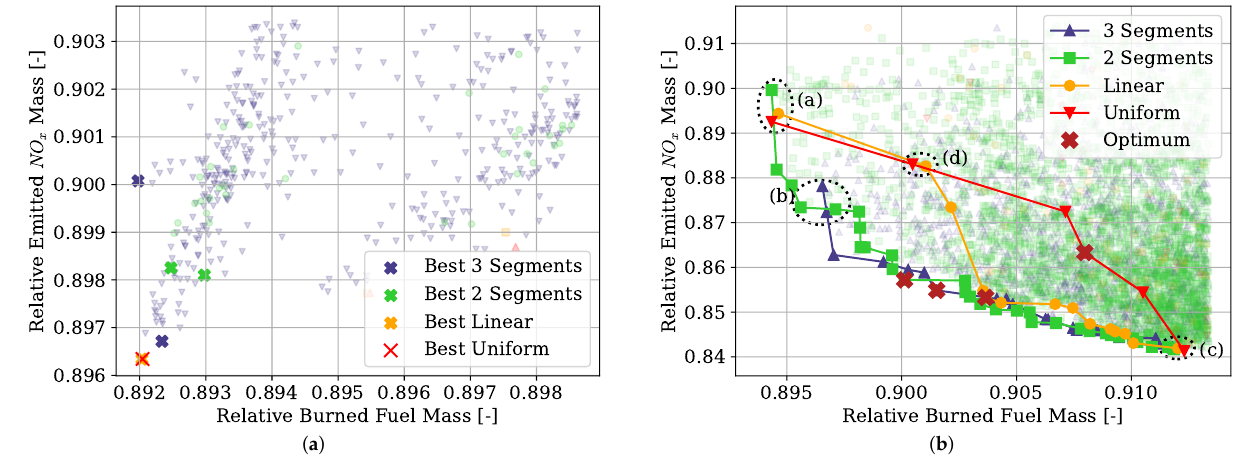
Figure 9. Effects of parametrisation complexity: ( a ) Optimal points Objective space of cruise-only hybridised strategies; ( b ) Pareto fronts of climb and cruise hybridisation strategies.